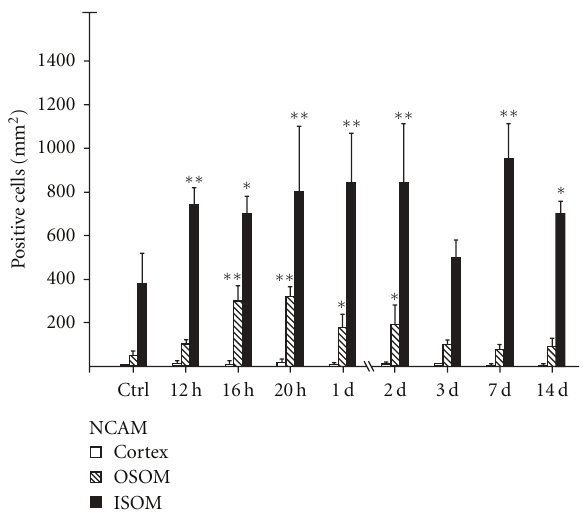
Figure 6: Distribution of NCAM immunoreactivity in the renal interstitium from controls (Ctrl) or from animals sacrificed at increasing time intervals (hours or days) after reperfusion. Each col- umn corresponds to the mean number of NCAM immunoreactive fusiform cells ( ± SD) after examination of cortex and outer medulla (OSOM, ISOM) for each experimental group ( n = 4) ( ∗ P < . 05; ∗∗ P < . 01 versus control).